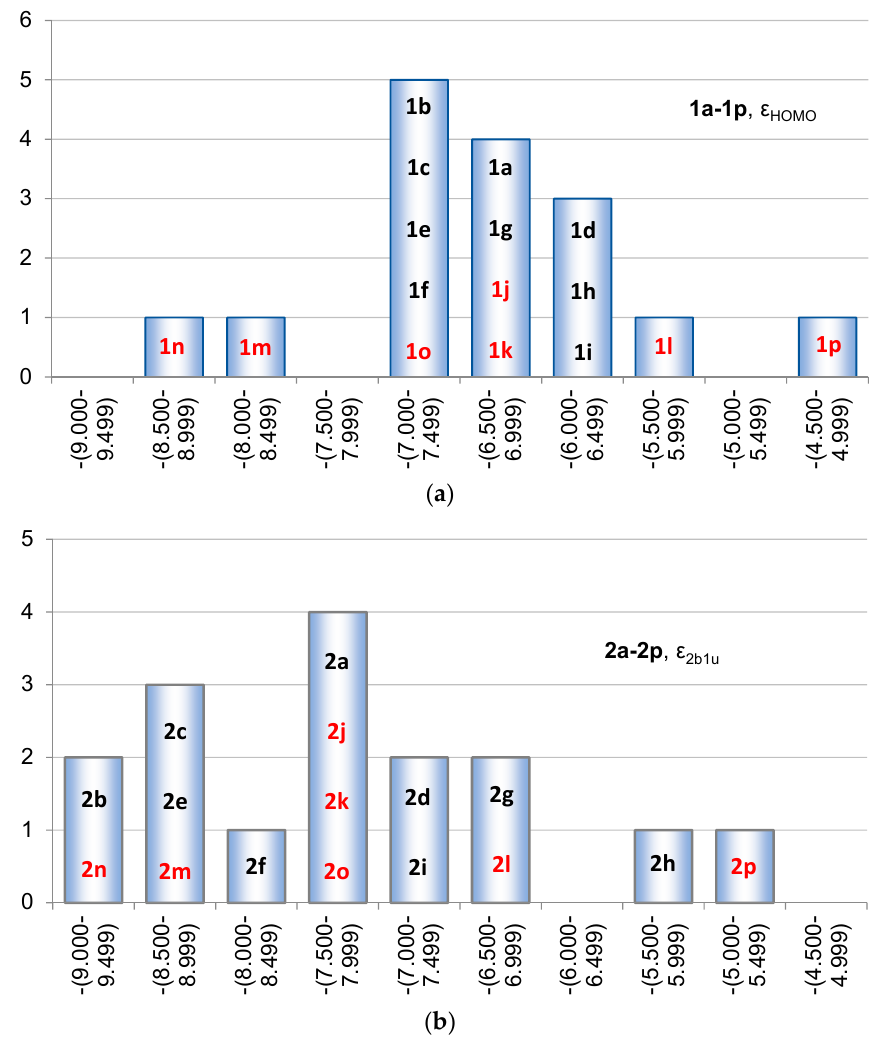
Figure 9. Distribution of ( a ) the ε HOMO for 1a – 1p and ( b ) the ε 2b1u for 2a – 2p ( ε HOMO for 2a ). Compound numbers of compounds substituted at the Si atoms in black and those substituted at the C atoms in red.